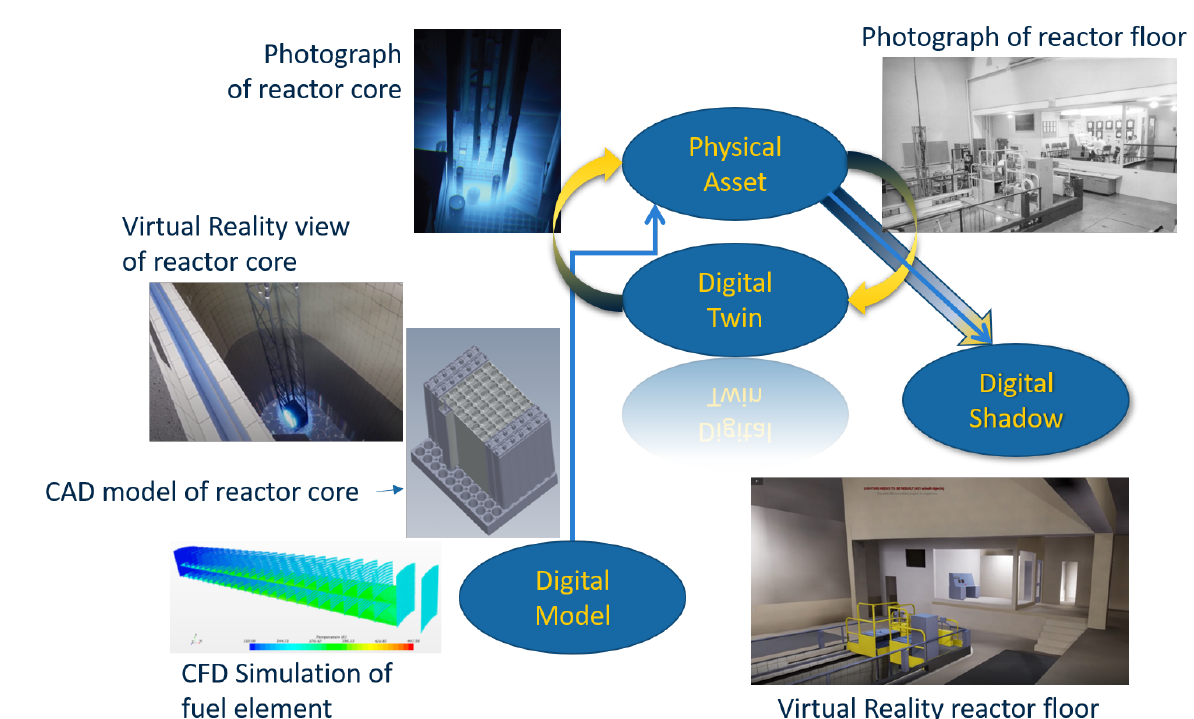
Figure 3. Relationship of Digital Model, Digital Shadow, Digital Twin, and the Physical Asset using images and models of the Ford Nuclear Reactor as an example. Large arrows represent automated information exchange and small arrows represent manual data